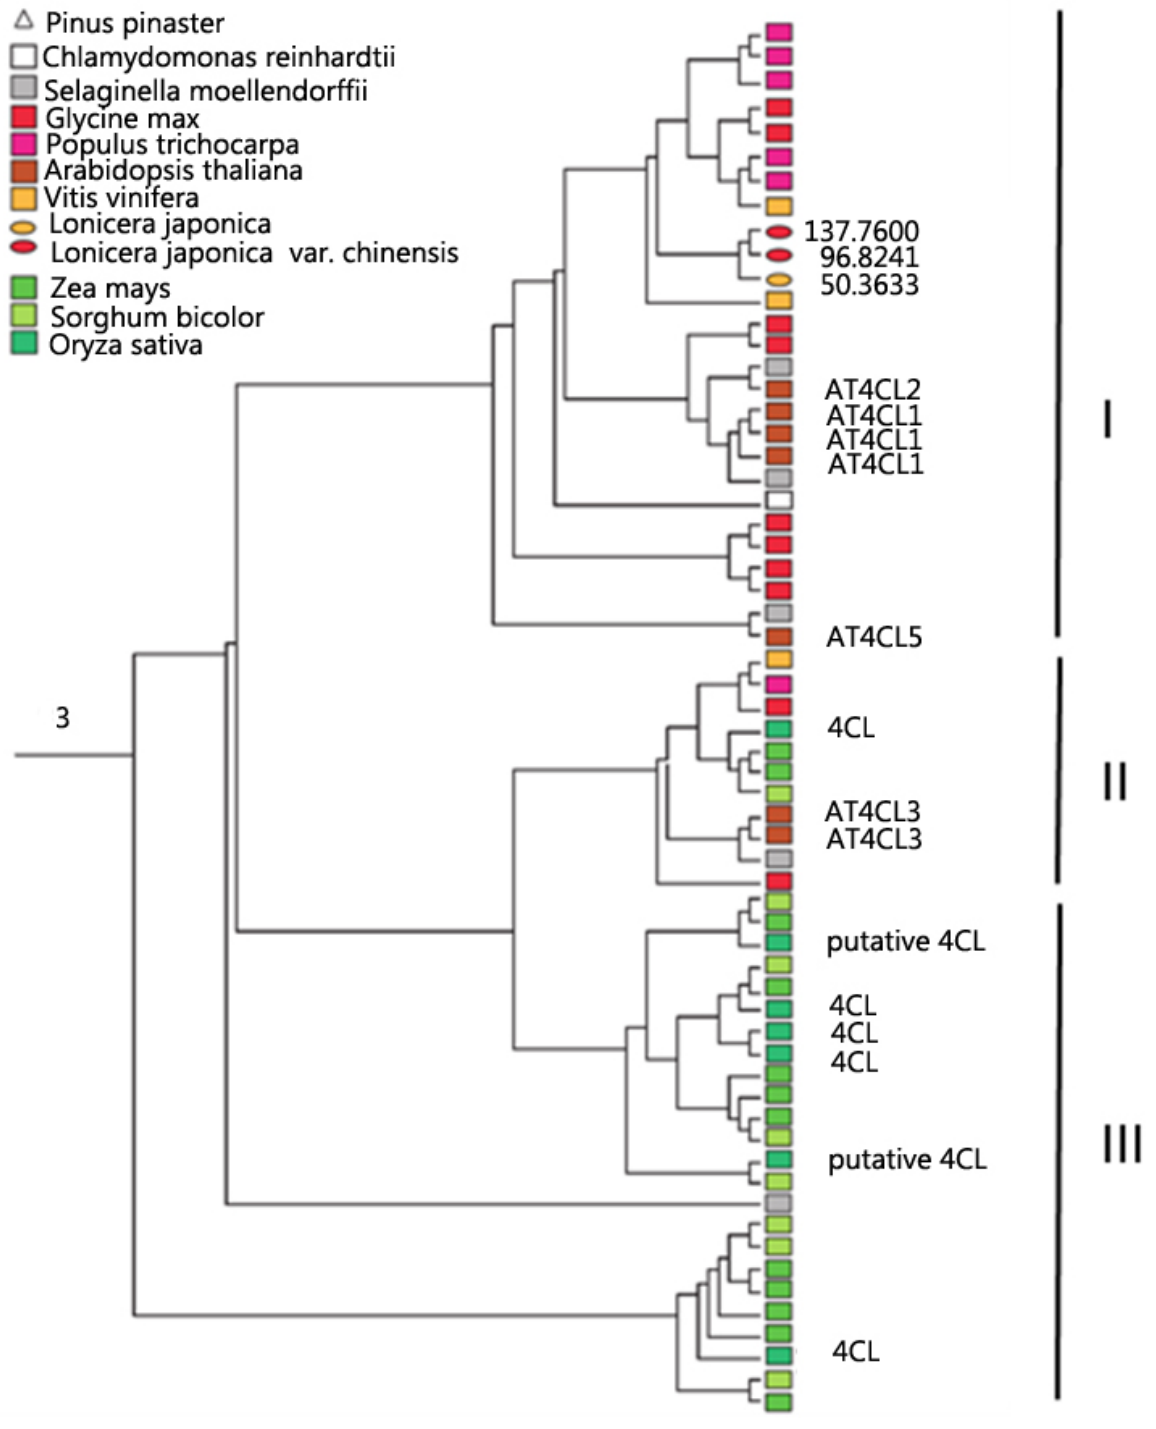
Figure 1. Phylogeny and expression of 4CL sequences in Cluster 3. A neighbor-joining tree containing 62 sequences was generated based on the AMP-dependent synthetase/ligase domain sequences. A bootstrap value of 1000 replications was applied. The RPKM value of sequences in flowers of Lonicera japonica is